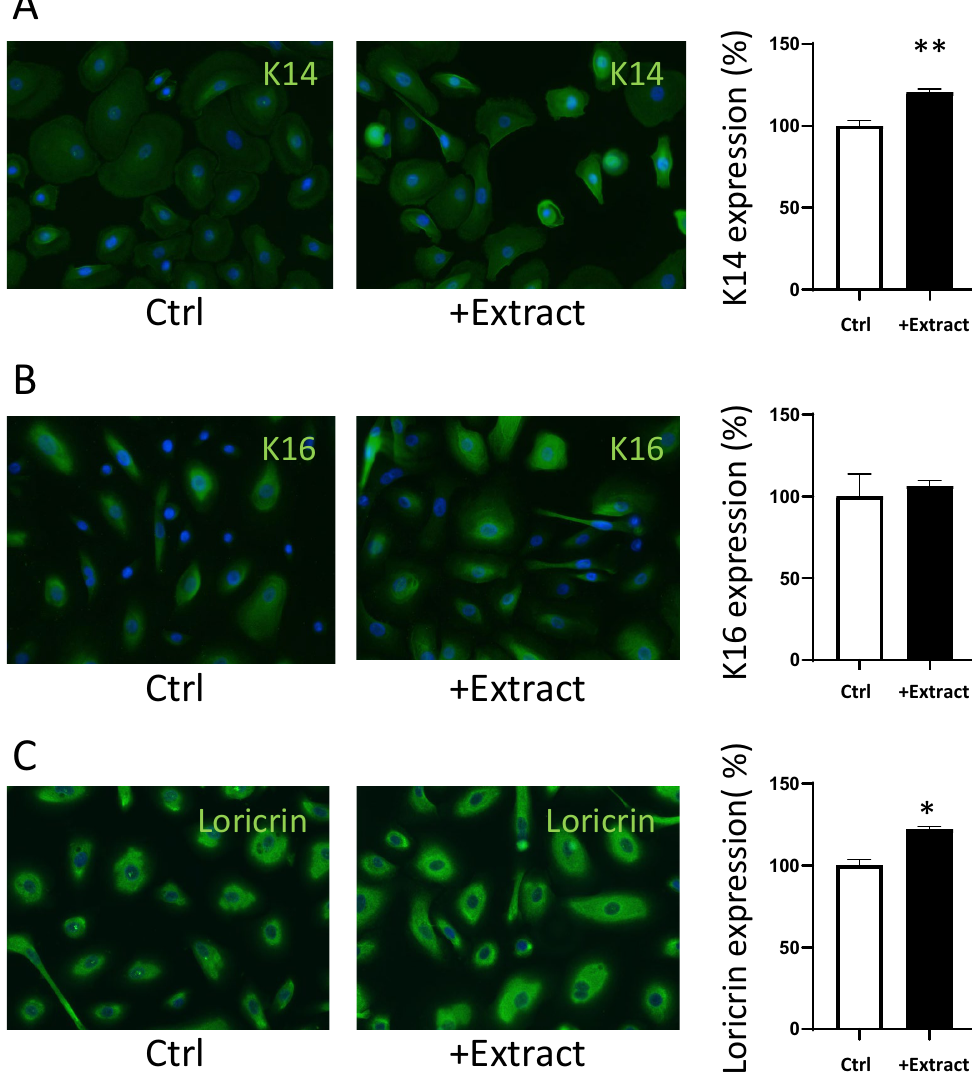
Figure 3. Treatment of KiPS cells with plant extract improved their terminal differentiation. ( A ) Keratin 14 protein immunofluorescent staining in KiPS cells after 48 h of treatment. KiPS-40 at day 8 post differentiation were treated, or not, in duplicate, with 1% JPPS (Extract) directly diluted in the culture medium, twice a day, for 48 h. Quantification of keratin 14 was done using Volocity software. ( B ) Keratin 16 protein immunofluorescent staining in KiPS cells after 48 h. ( C ) Loricrin protein immunofluorescent staining in KiPS cells after 48 h. Statistical analyses are represented as black and white bars (mean ± sem; n = 3; * P < 0.05, with Student’s t